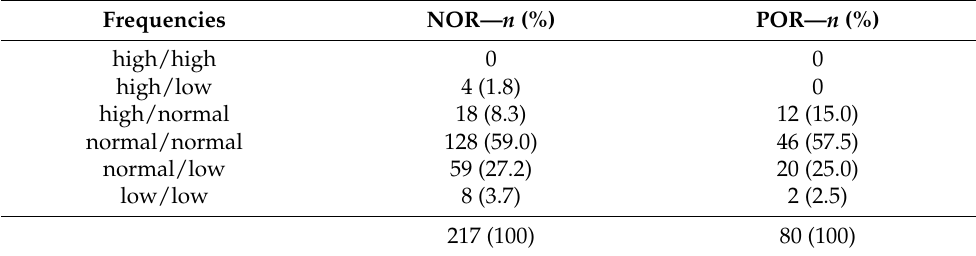
Table 6. FMR1 genotype distribution of patients with different response patterns. Frequencies NOR— n 309